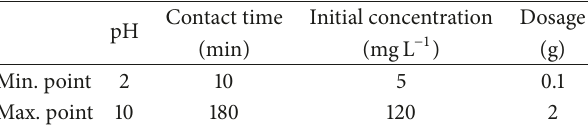
Table 1: Experimental domain.